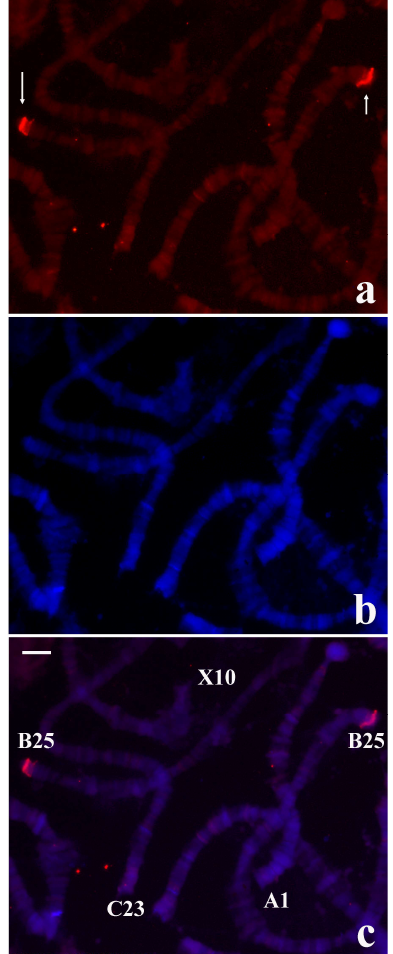
Figure 7. ( a ) Localization of the probe (red signal) synthesized with DNA from the microdissected B-1 tip of R. americana in chromosomes of T. pubescens. ( b ) The same chromosomes stained with DAPI and ( c ) the corresponding merged signals. The arrows point to the main labelling restricted to chromosome ends B-25. Bar = 15 µ